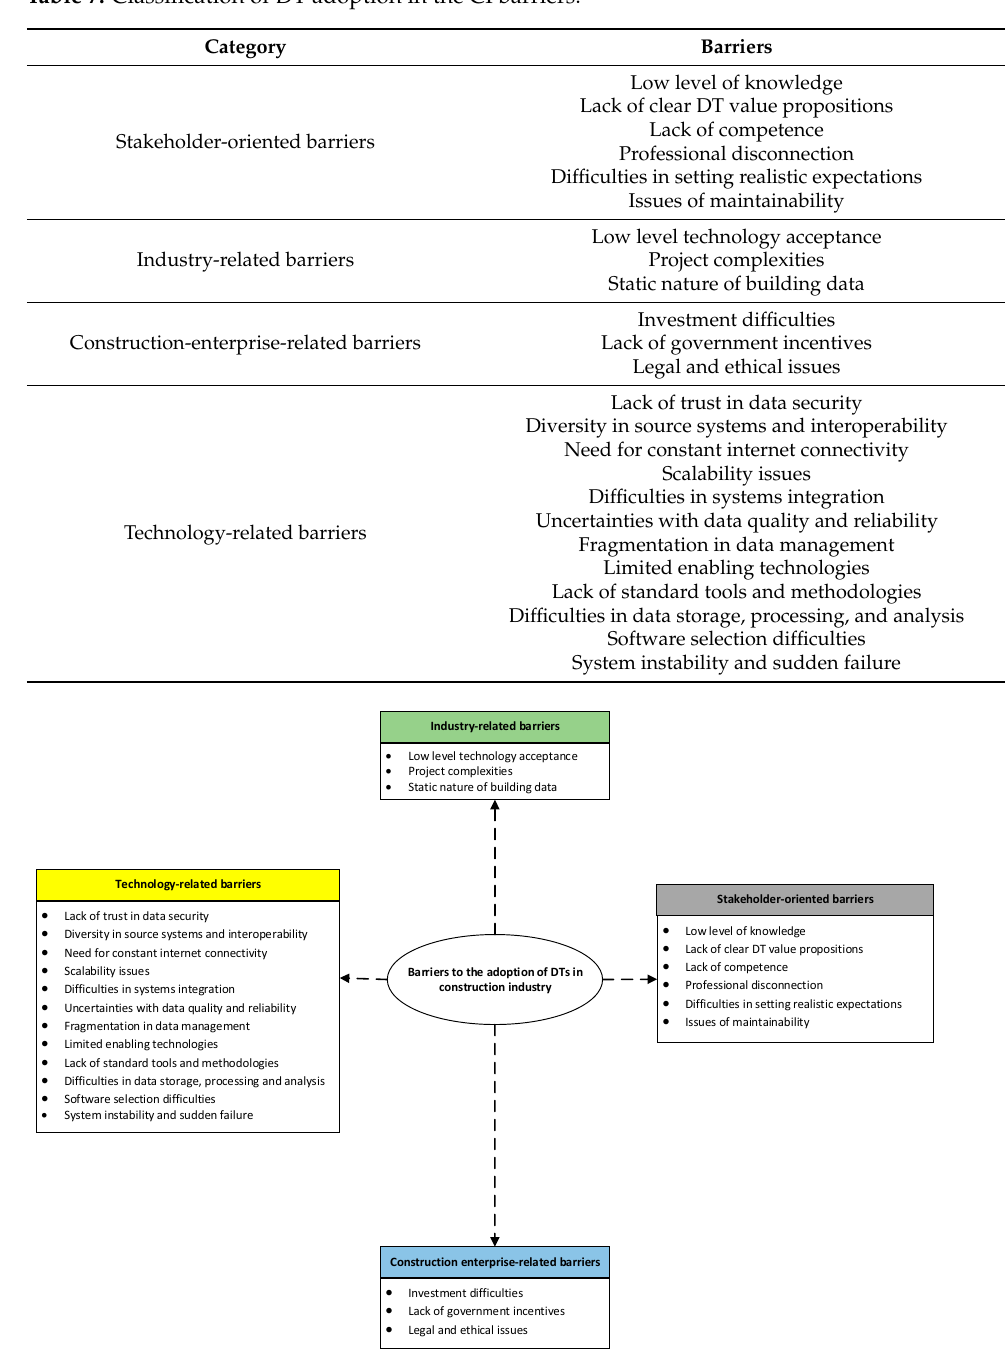
Figure 8. A conceptual framework for the categorisation of the key barriers to the adoption of DT in the CI.